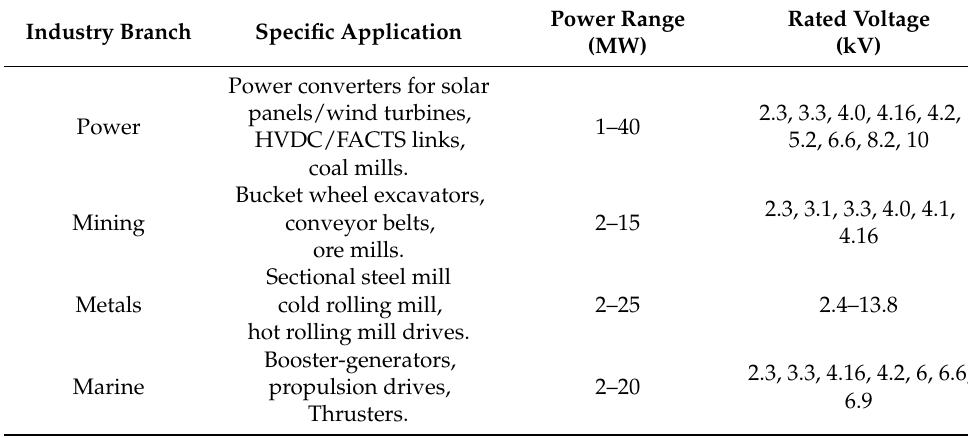
Table 1. Industry applications of high-power AFE